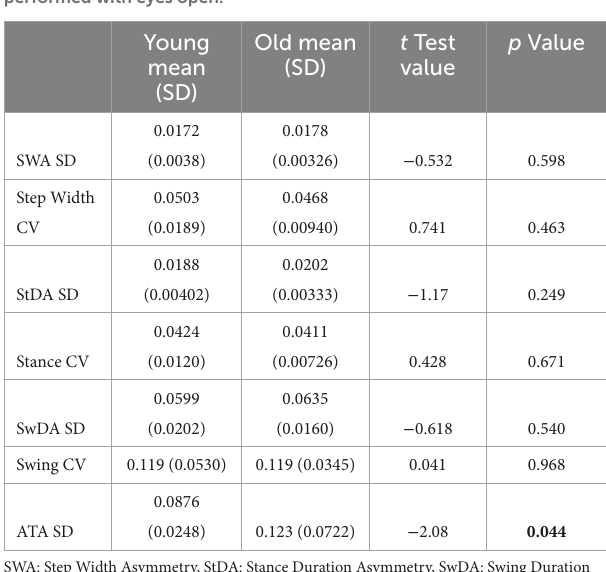
TABLE 1 Comparison of standard deviation (SD) of asymmetry measures and coefficient of variation (CV) of gait measures in young versus old subjects on self-paced and non-perturbed stepping-in-place tests performed with eyes open.